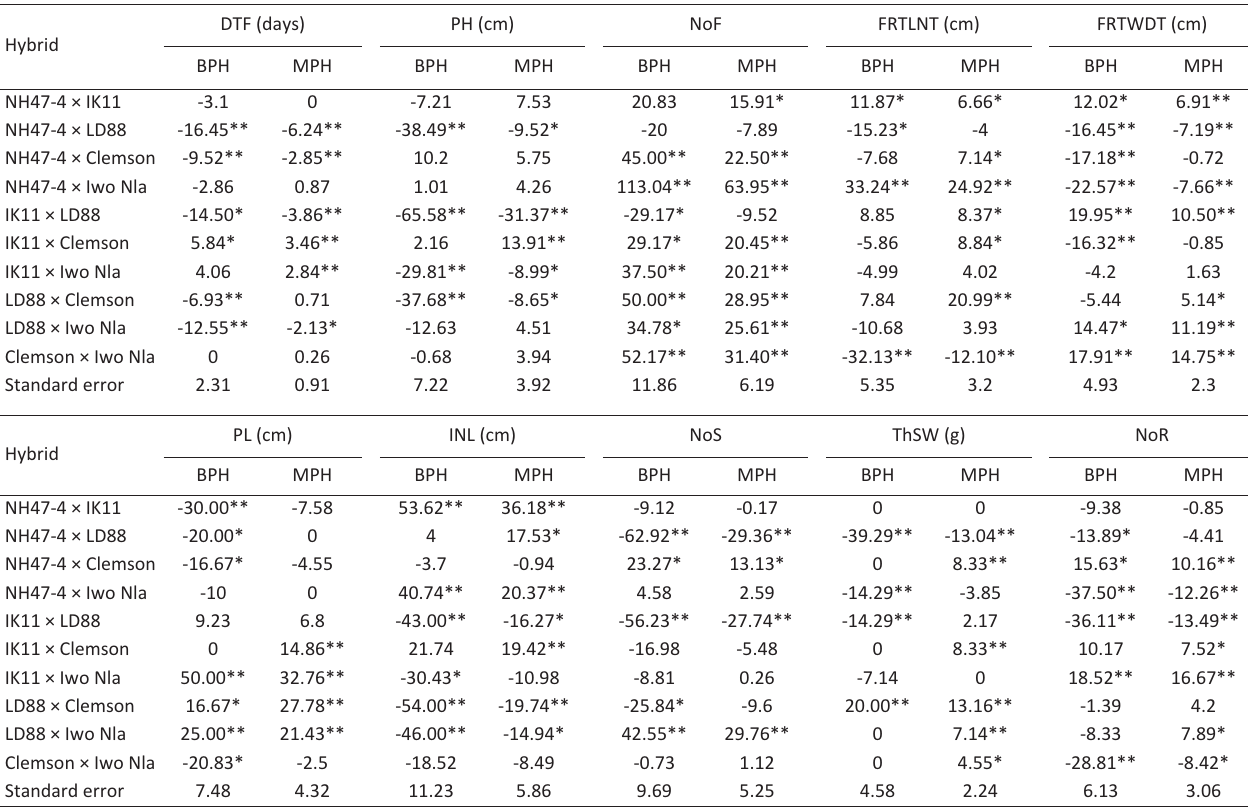
*,** significant at p≤0.05 and p≤0.01 respectively; BPH and MPH= Better­ and Mid­parent heterosis, respectively; DTF= days to 50% flow­ ering; PH= plant height at maturity; NOF= number of fruits per plot; LNT= fruit length; FWT= fruit circumference; PL= Pedicel length; INL= internodal length; NOS= number of seeds per pod; THS= 1000­seed weight; NOR= number of ridges per